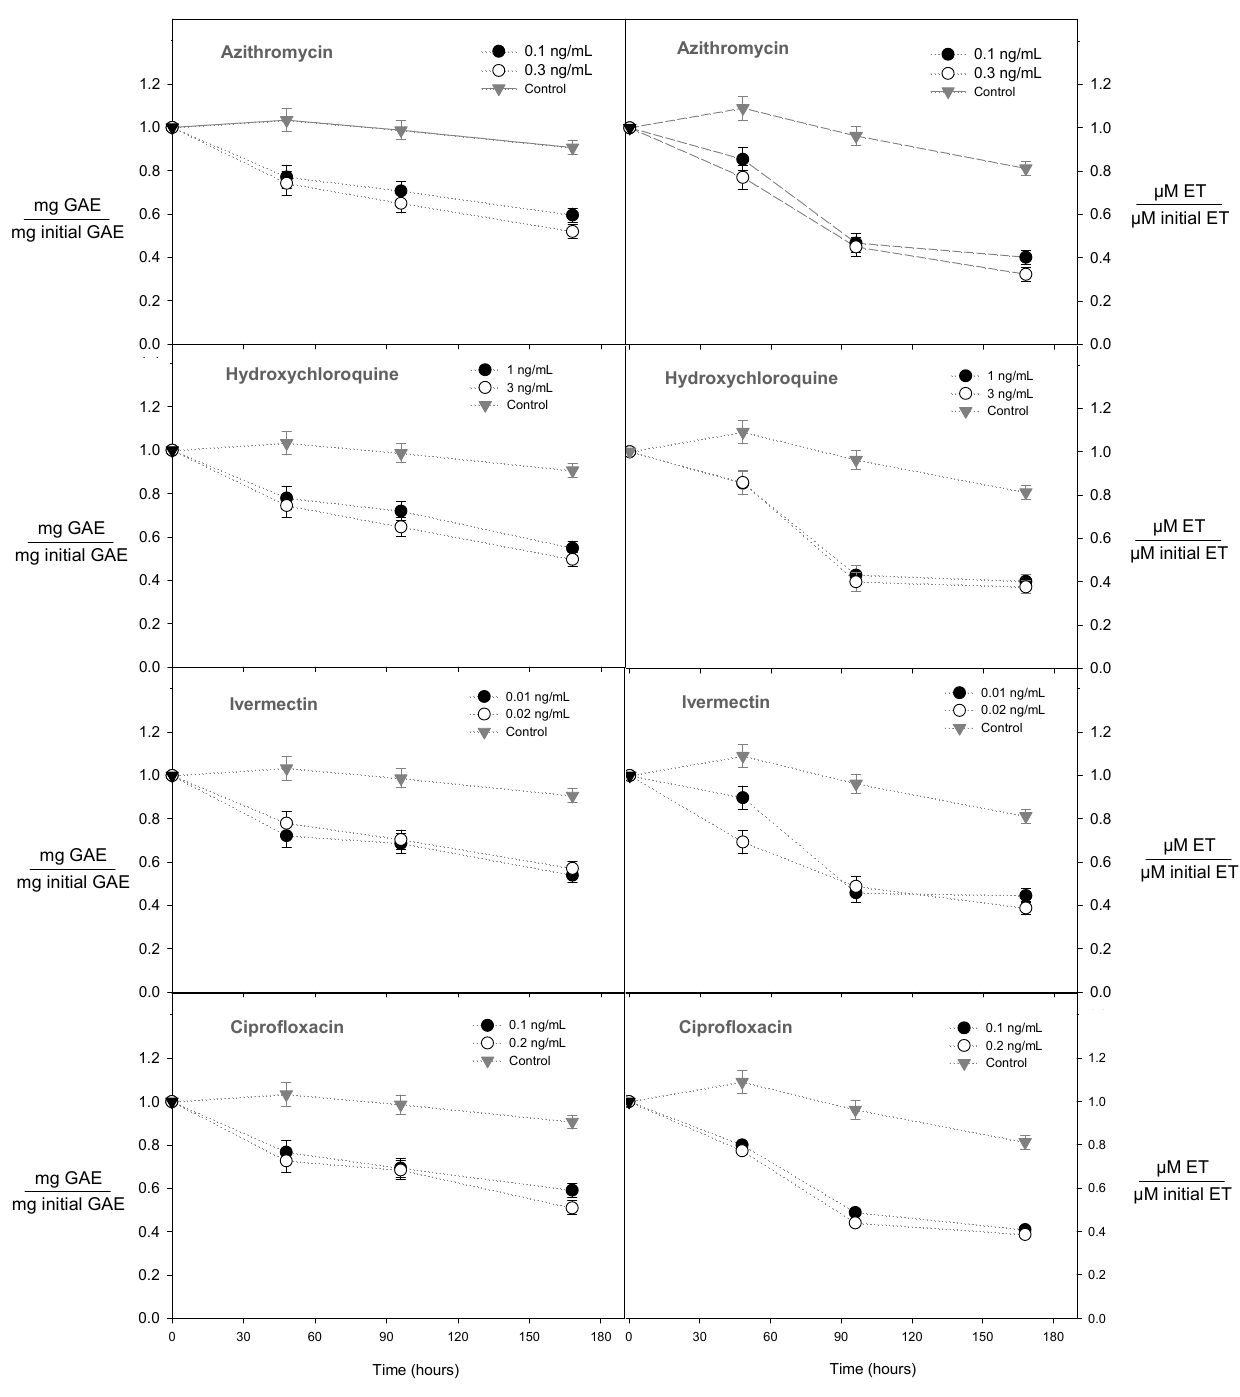
Figure 1. Effect of antibiotic type on total polyphenol content and antioxidant capacity during the fermentation process.